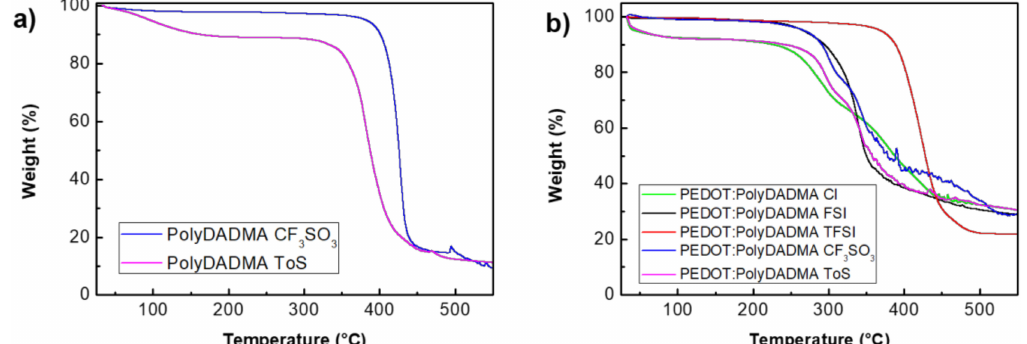
Figure 3. ( a ) Thermogravimetric analysis (TGA) curves of the neat PolyDADMA CF 3 SO 3 and Tos polyelectrolytes and ( b ) TGA curves of PEDOT:PolyDADMA Cl, FSI, TFSI, CF 3 SO 3 and Tos polyelectrolytes. PolyDADMA = poly(diallyldimethylammonium); CF 3 SO 3 = triflate; Tos = tosylate; PEDOT = poly(3,4-ethylenedioxythiophene); Cl = chloride; FSI = bis(fluorosulfonyl)imide; TFSI =